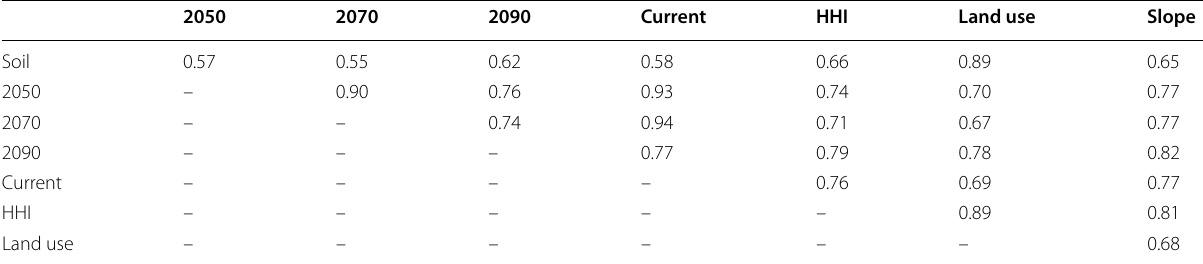
Table 10 Niche overlap Hellinger’s I values between various bioclimatic and non-bioclimatic variables (individual)